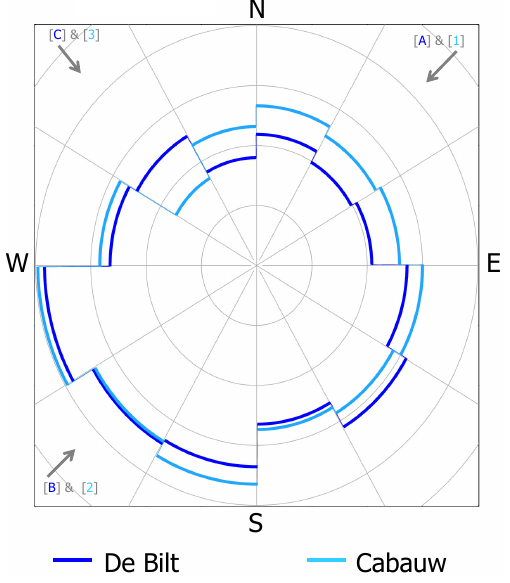
Figure 13. Tropospheric NO 2 columns from Lotos-Euros, aver- aged for 12 sectors of wind direction, for the locations De Bilt and Cabauw. The radius of the inner circle is 5 · 10 15 moleccm − 2 . The arrows correspond to wind directions shown in Fig. 12.